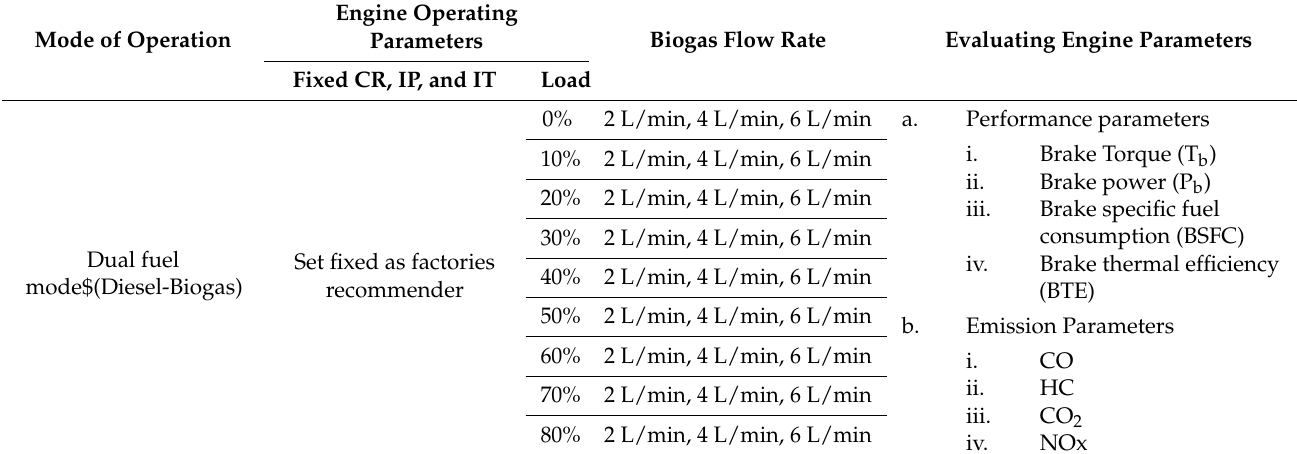
Table 5. Experimental test matrix for dual fuel mode